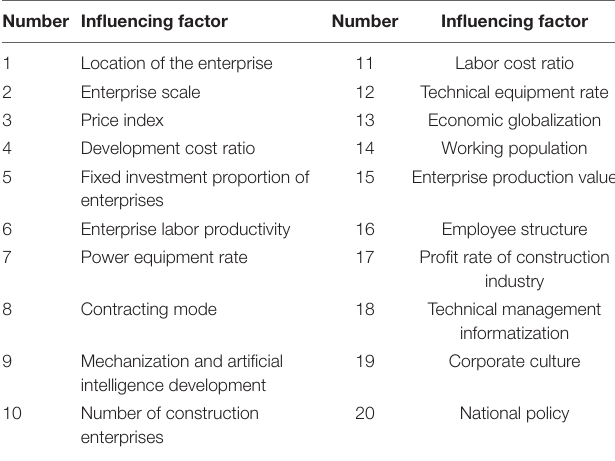
TABLE 2 | The influencing factors. Number Influencing